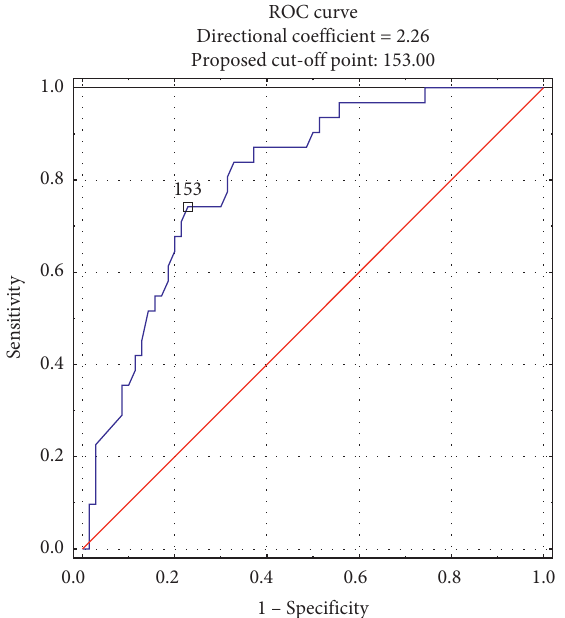
Figure 2: Receiver operating characteristic (ROC) curves for GRACE risk score in the prediction of 7-year mortality in patients with Takotsubo syndrome 1 −